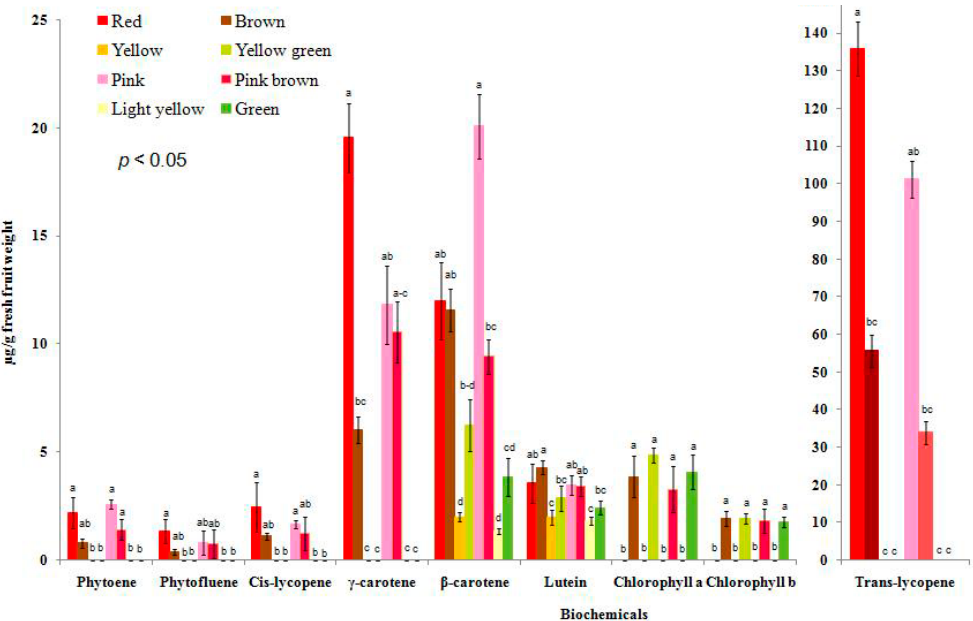
Figure 4. Biochemical profiles of the eight different fruit color phenotypes in the F 2 population of the cross between the red-fruited line (KNR3) and the green-fruited line (BUC30). Values indicate the mean of the HPLC results of five fruit harvested from three randomly-selected plants for each fruit color 57 days after pollination. Error bars are the standard deviation (SD) values of the HPLC results of the respective fruit color. Different letters indicate significance differences among the fruit phenotypes for the particular biochemicals tested at the p < 0.05 level.